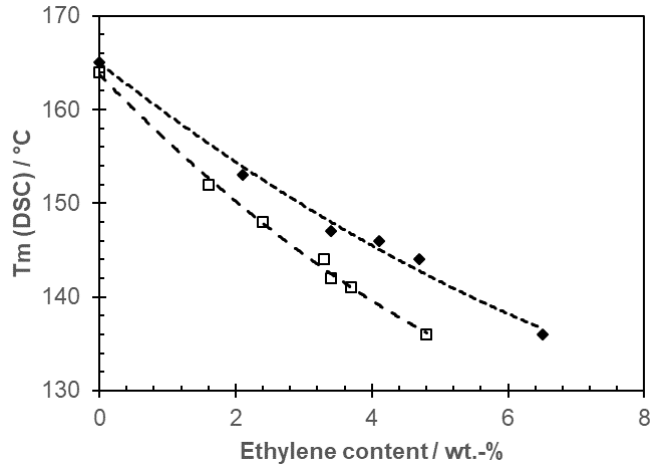
Figure 8. Melting point as function of ethylene content for monomodal random copolymers based on emulsion-type catalyst with phthalate (full symbols) and citraconate (open symbols; data from [47,60]).